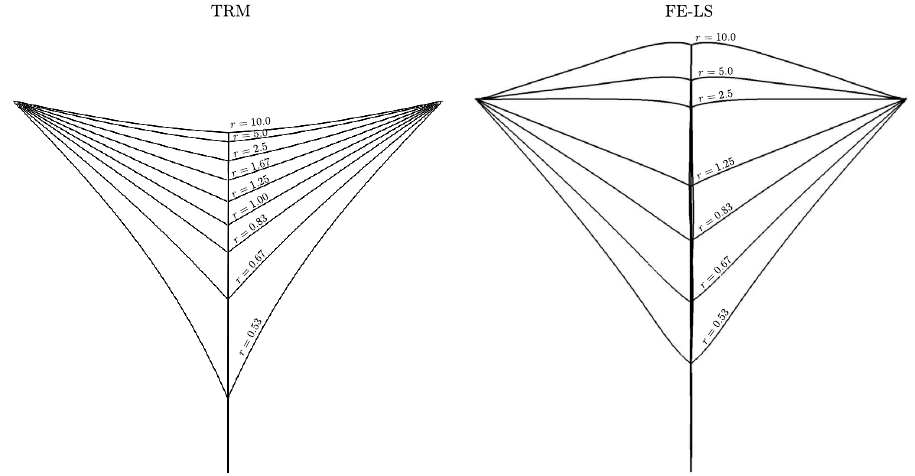
Figure 6. Triple junction test case: final interface states for the ( left ) TRM and ( right ) LS-FE models. The displayed for the LS-FE model was taken from [8].